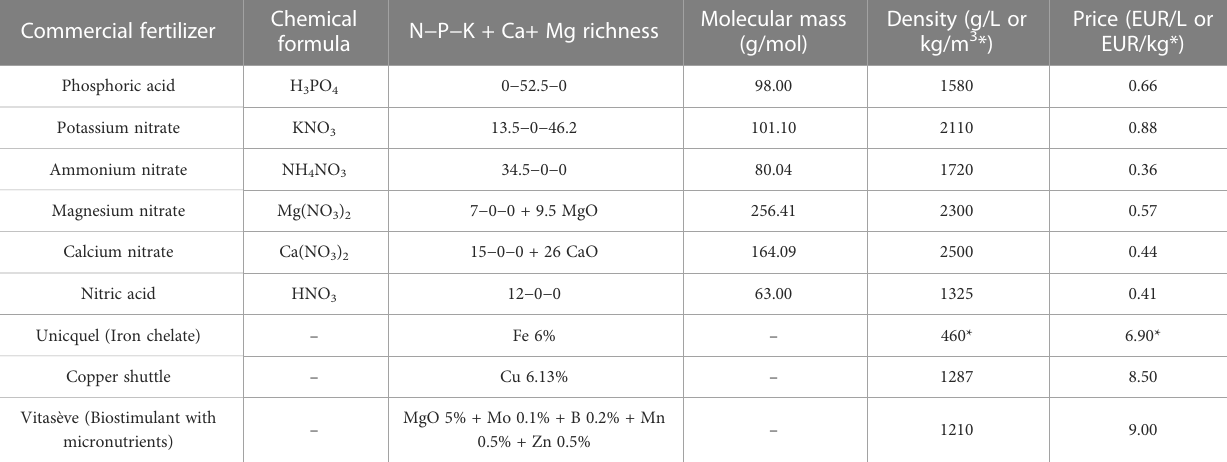
TABLE 2 Average price and main properties of fertilizers used in the trial.